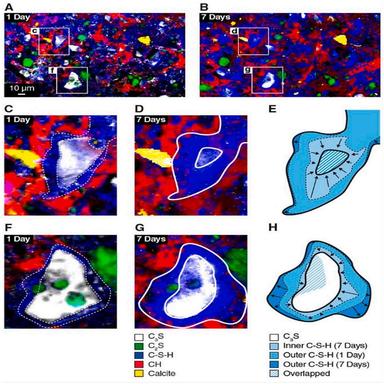
Raman maps of hydrated Portland cement at 1 and 7 days of hydration (a, b) Raman component maps (C3S: white, C2S: green, C–S–H: blue, CH: red, calcite: yellow) of a cement paste after one day and seven days of hydration. (c, d) and (f, g) Magnified images of two C3S clusters are compared with C3S and C–S–H boundaries highlighted with lines. (e, h) The C3S clusters after one day and seven days are compared. The C–S–H growth direction is marked with arrows and inner/ outer C–S–H are differentiated depending